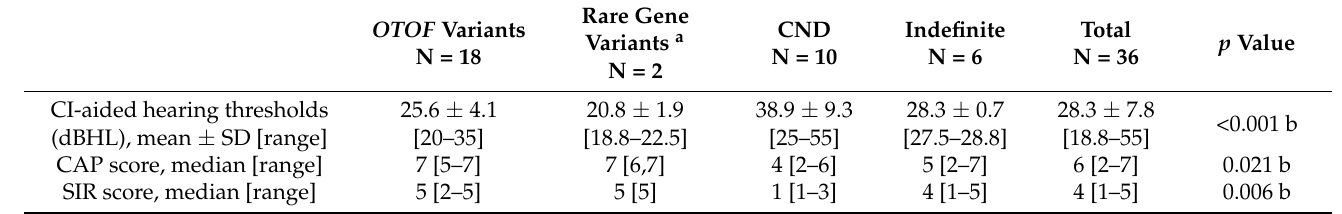
Table 3. Cochlear implantation outcomes in patients with auditory neuropathy spectrum disorder of different